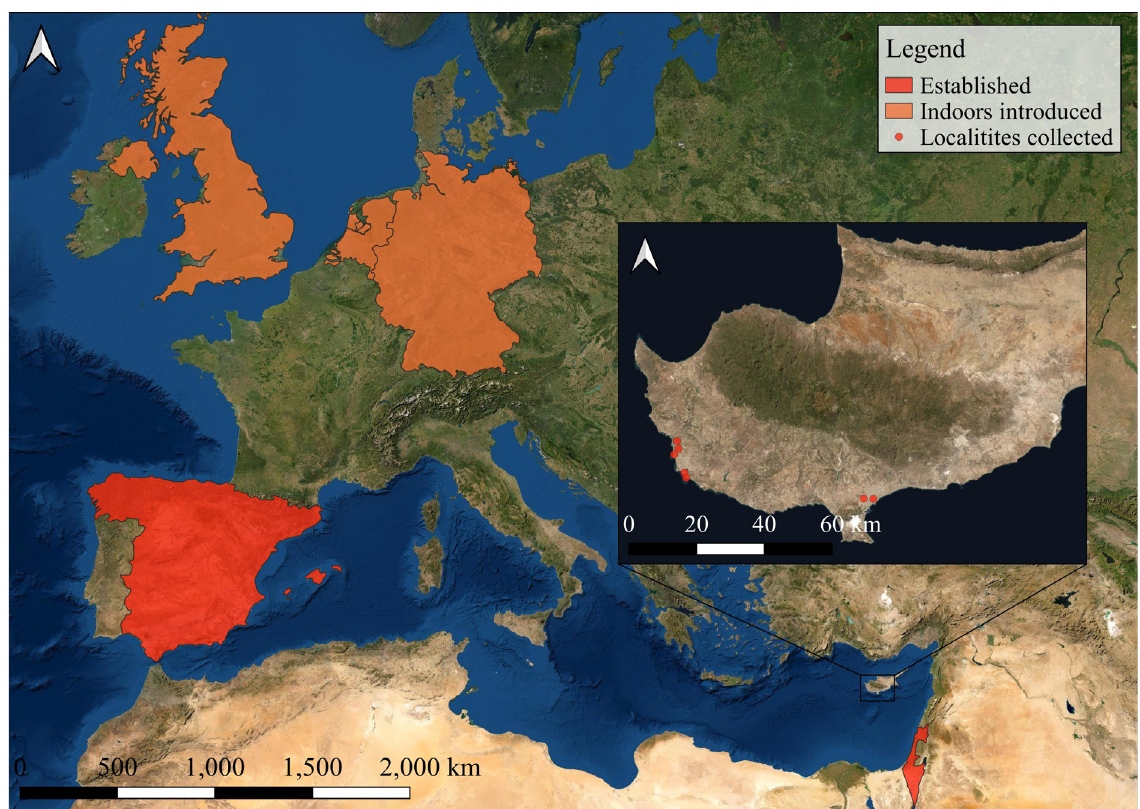
Fig 2 . Current known distribution of Wasmannia auropunctata (Roger, 1863) in the Mediterranean Basin and Cyprus